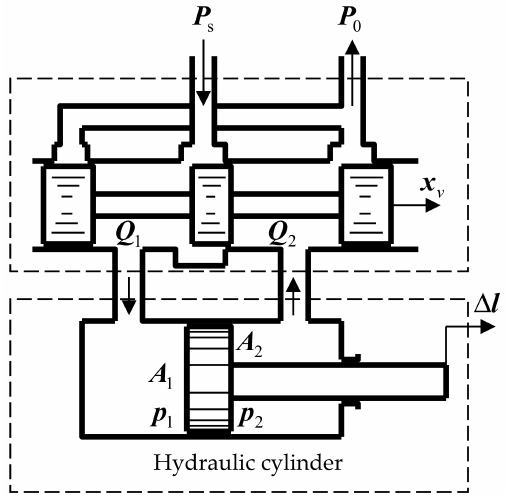
Figure 4. Diagram of hydraulic servo control